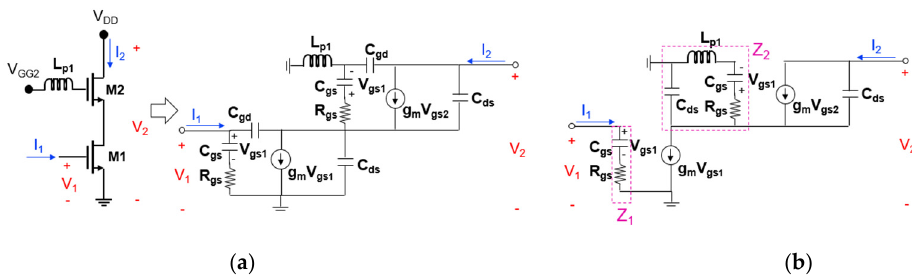
Figure 8. Transistor equivalent circuits of the cascode mixer when the first positive feedback in- ductor (L p1 ) is added to the gate node of the upper transistor (( a ) two-port representation and ( b ) simplified